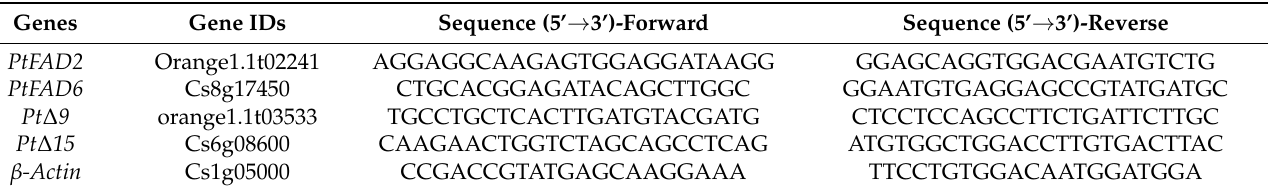
Table 1. Primer sequences of selective